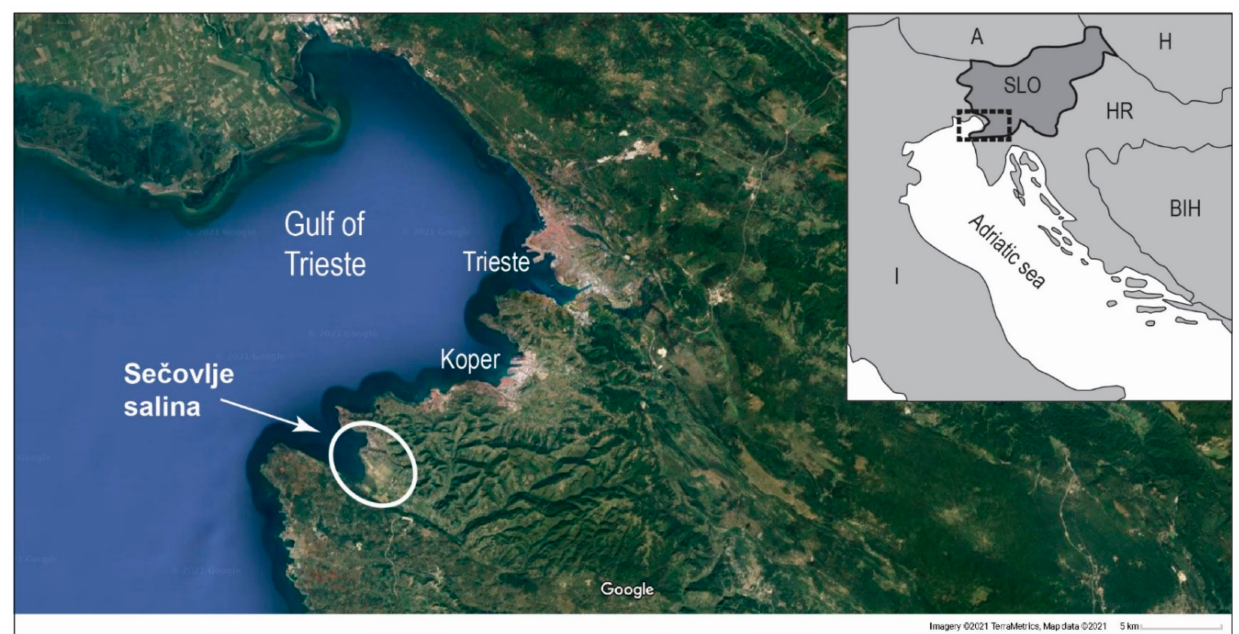
Figure 1. The research area of Seˇcovlje Salina—Bay of Piran (Northern